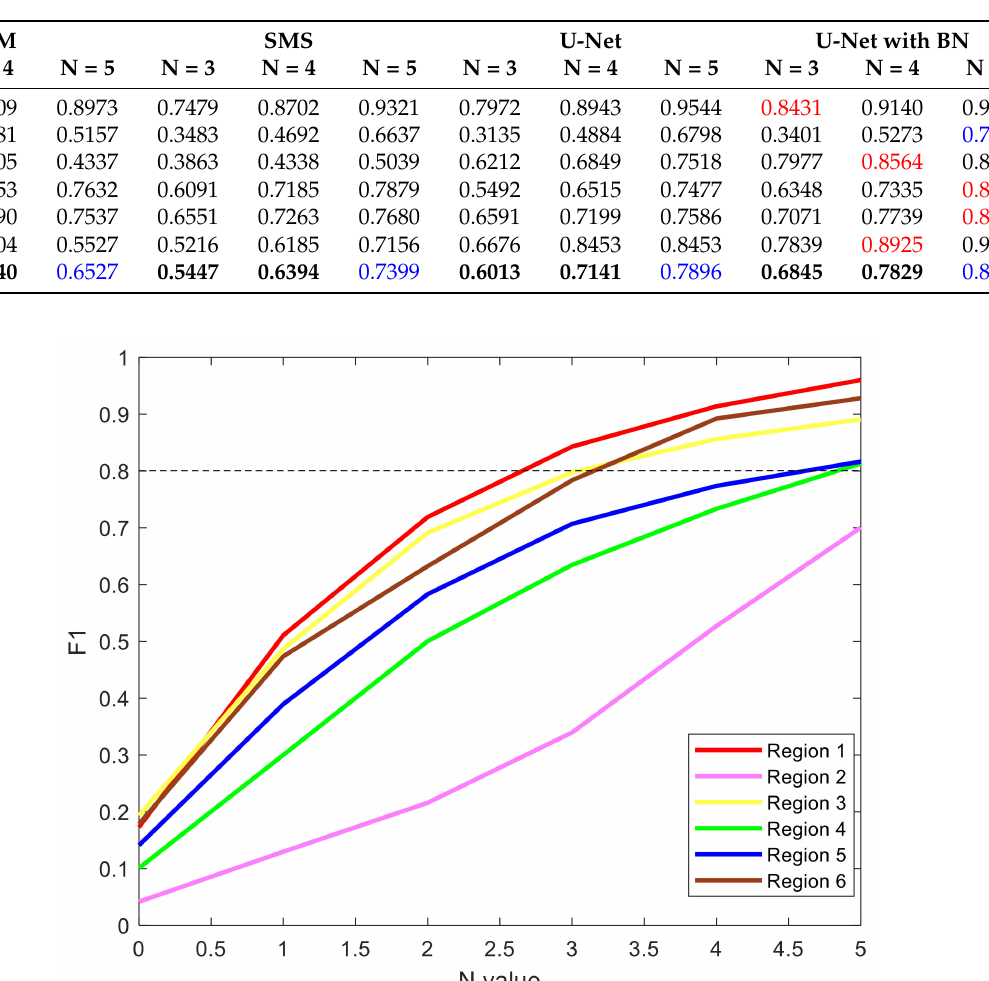
Table 4. F1-measure of six regions by comparing the proposed U-Net model and other methods with the ground truth data.